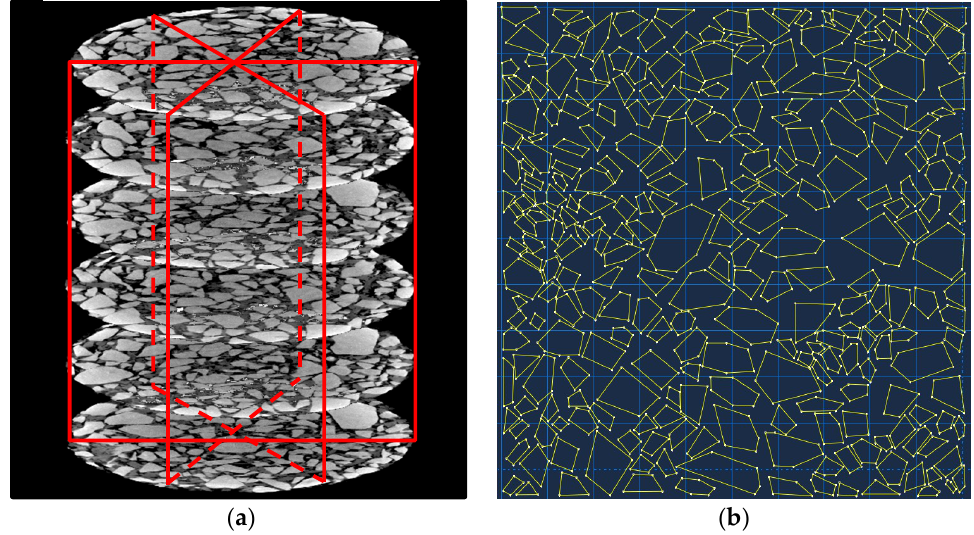
Figure 7. Mesostructure of the asphalt mixture: ( a ) Vertical section of the mixture sample; ( b ) aggregate skeleton sketch in ABAQUS.